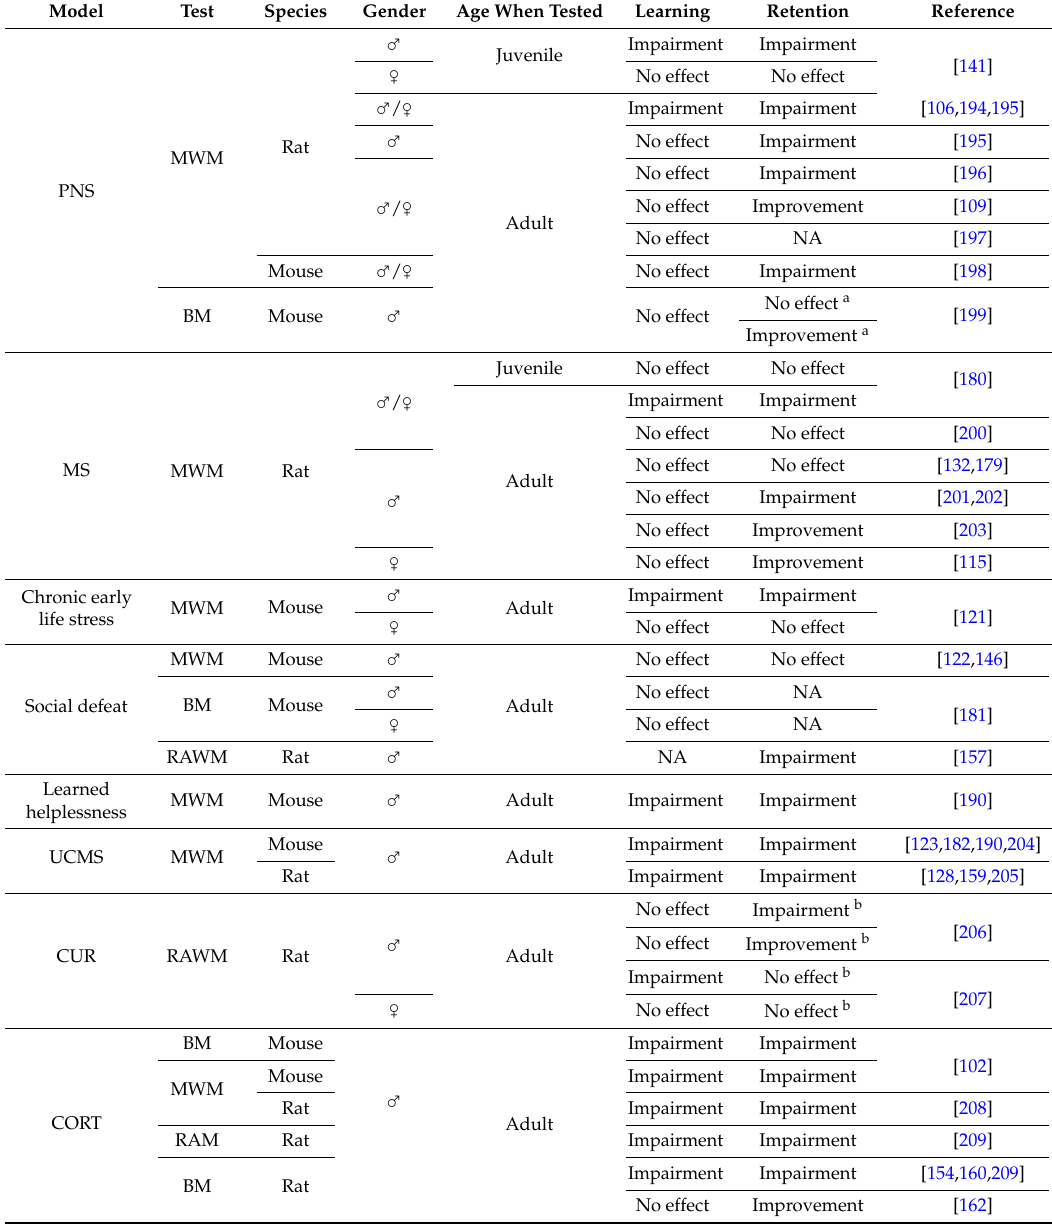
Visuo-spatial learning and retention performances in different rodent models of